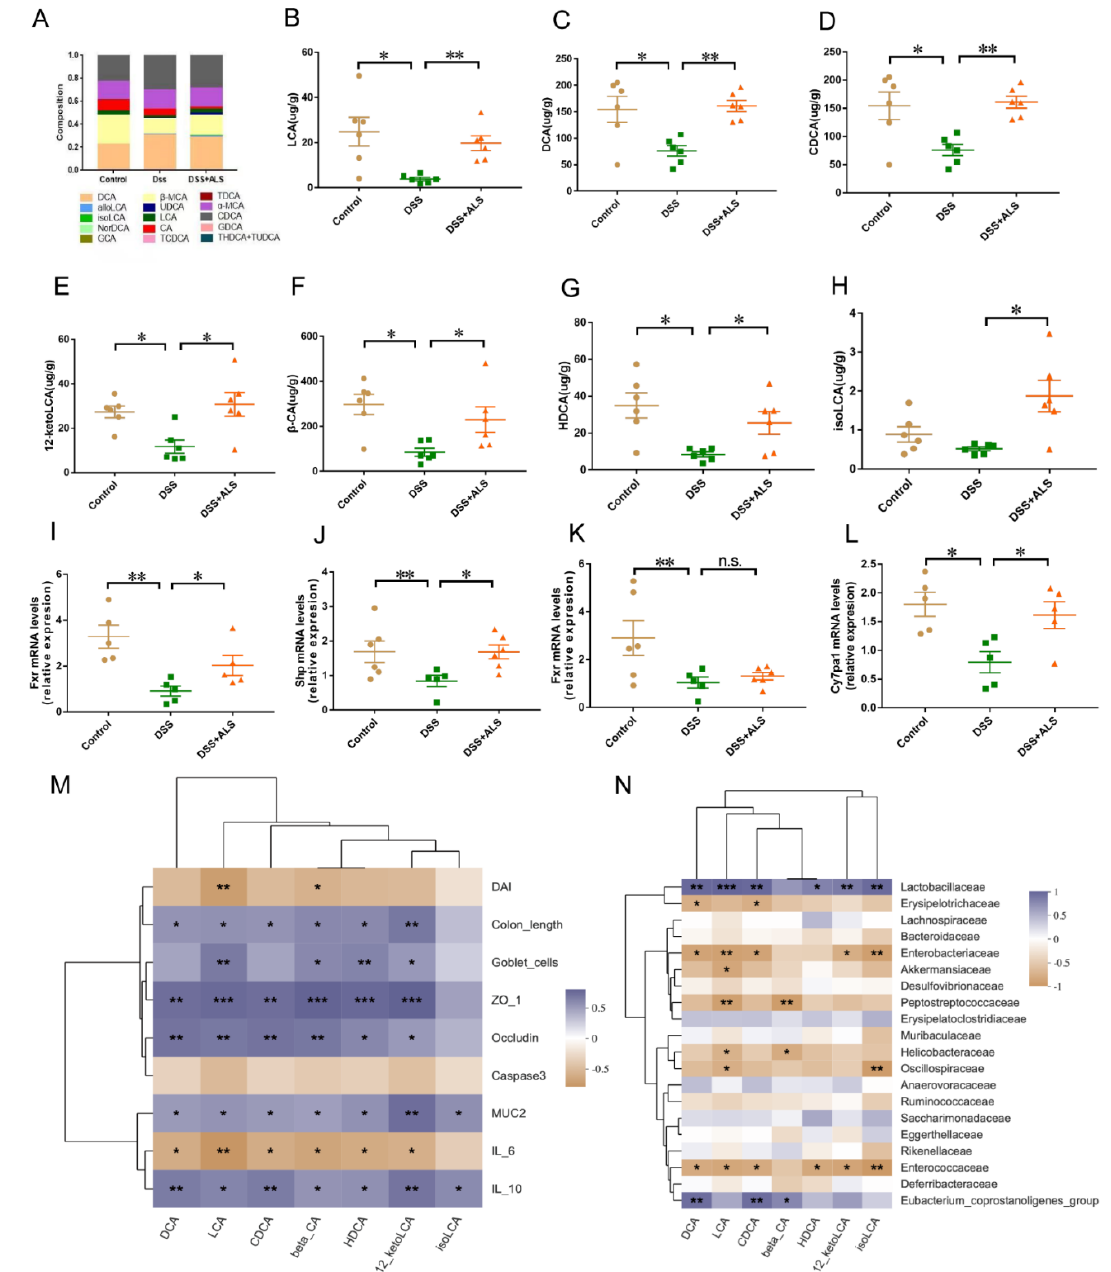
Figure 6. ALS increases the production of microbial Bas. ( A ) The relative abundance of bile acids in the cecum content. ( B – H ) Significantly altered BAs quantification ( I , J ) Measurement of Fxr and Shp genes in colon tissues. ( K , L ) Measurement of Fxr and Cyp7a1 gene in liver. ( M ) Analysis of the Spearman’ correlation between significantly altered BAs and colitis-related parameters. ( N ) Analysis of Spearman’ correlation between significantly altered BAs and microbiota. Data are mean ± SEM. n = 5–6 per group. * p < 0.05, ** p < 0.01 and *** p < 0.001. n.s., not statistically significant.